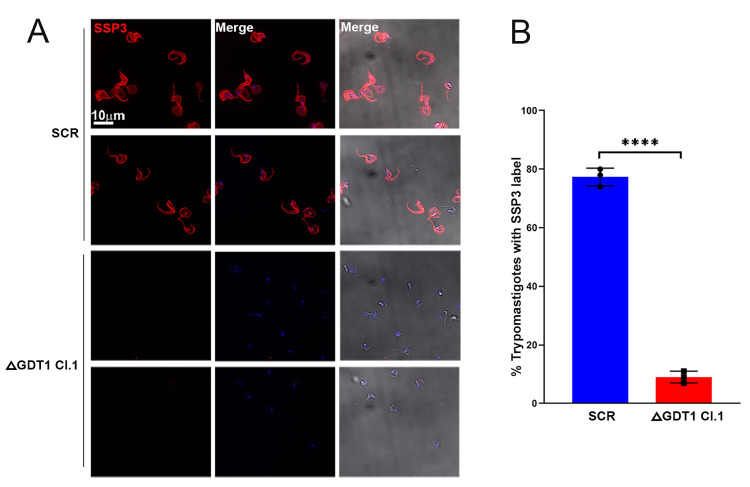
Effects on trypomastigotes Ssp3 expression.(A) Ssp3 expression in control (Scr) and TcGDT1-KO clone 1, as determined by immunofluorescence analysis (IFA) using anti-Ssp3 antibodies. Anti-Ssp3 staining of the plasma membrane (red) can be observed in control (Scr) but not in TcGDT1-KO clone 1 trypomastigotes, using the same antibody dilution and exposure conditions. (B) A total of 200 control (Scr) or TcGDT1-KO clone1 trypomastigotes were counted and percent trypomastigotes showing Ssp3 staining in plasma membrane were plotted. Values are means of three biological replicates ± s.d., n = 3, ****p < 0.0001. Statistical analysis was performed using the Student’s t-test.